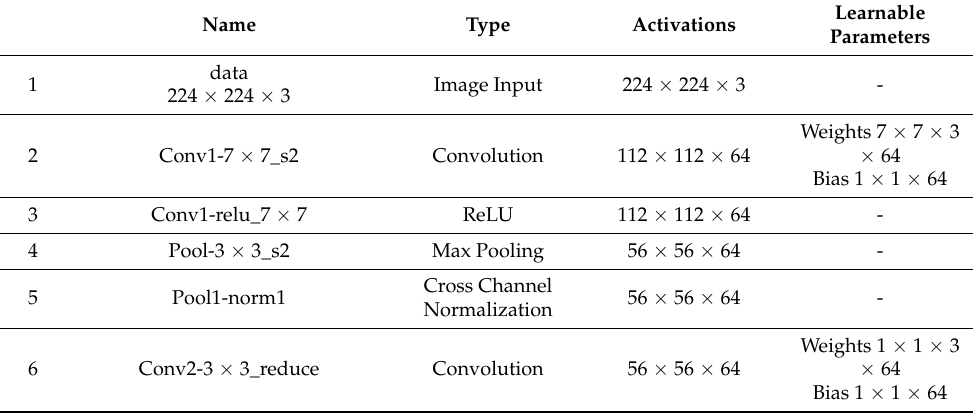
Table 6. Summary of parameters for